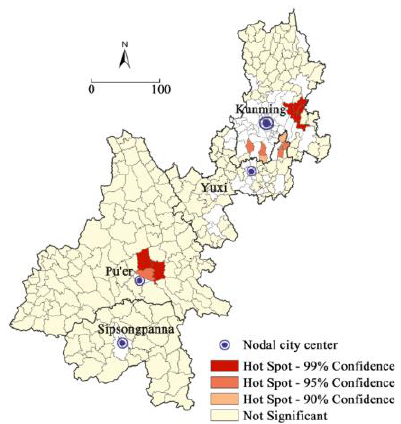
Figure 5. Clustering results of small towns in terms of integrated evaluation. Table 5. Cluster results of industrial development